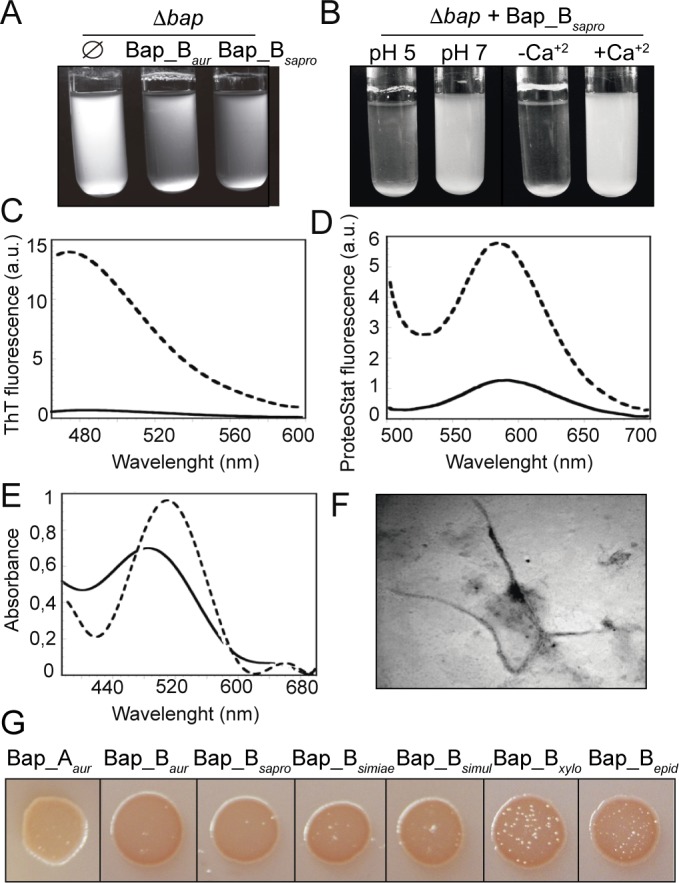
Amyloidogenic behavior of Bap_B orthologous proteins.A) Bacterial clumping of S. aureus Δbap mutant expressing Bap_B chimeric protein of S. saprophyticus (Bap_Bsapro). As a control, Bap_B chimeric protein of S. aureus was used (Bap_Baur). B) Bacterial clumping of S. aureus Δbap expressing Bap_Bsapro cultured in LB (pH 7) and LB-glu (pH 5) and in LB-glu supplemented with 20 mM CaCl2. Cell clumps of 3 independent experiments were quantified (S1E Fig). C) Increase in ThT fluorescence emission upon binding to 0.1 mg/ml rBap_Bsapro ring aggregates (dashed line). Free ThT emission spectrum is represented (solid line). D) Increase in ProteoStat fluorescence emission upon binding to 0.1 mg/ml rBap_Bsapro ring aggregates (dashed line). Free ProteoStat emission spectrum is represented (solid line). E) Shift in CR absorbance spectrum upon binding to 0.1 mg/ml rBap_Bsapro aggregates (dashed line). Free CR absorbance spectrum is represented (solid line). F) Electron micrograph of negatively stained aggregates formed by Bap_Bsapro. G) Variation in colony color phenotype of E. coli cells exporting the Bap_B orthologous proteins grown on agar supplemented with CR. Bap_Bsimiae: Bap_B from S. simiae, Bap_Bsimul: Bap_B from S. simulans, Bap_Bxyl: Bap_B from S. xylosus, Bap_B epid: Bap_B from S. epidermidis. As negative control Bap_A from S. aureus was used (Bap_Aaur).